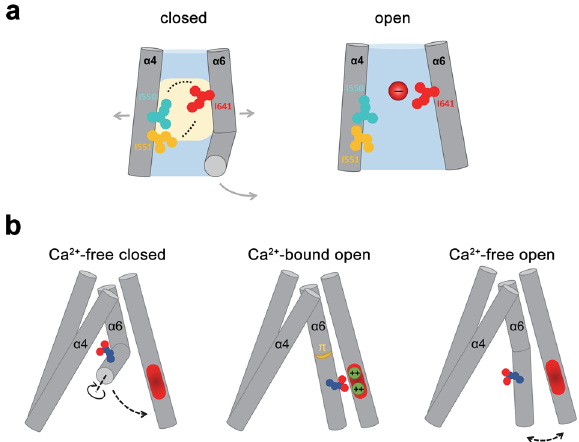
Fig. 7 Relationship between non-conducting and conducting conformations. a Schematic illustration of the hydrophobic gate at the inner entrance of the narrow neck that prevents ion conduction in the closed state (left). Functional interactions between hydrophobic residues are indicated by dashed lines. Beige area indicates putative de-wetted region that excludes water in the closed conformation. In the open conformation (right), the residues of the gate have dissociated leading to a widening of the pore and a retraction of gate residues on α 4. b Relationship between conducting and non-conducting conformations in the presence and absence of Ca 2 + . In the non-conducting apo conformation of WT (left), the intracellular half of α 6 has moved away from the Ca 2 + binding site. Upon Ca 2 + binding, α 6 rearranges its conformation by moving towards the Ca 2 + binding site. The subsequent rotation around the helix axis, to bring a residue in contact with bound Ca 2 + ions, introduces a strained π -helix conformation. The movement of α 6 couples to the gate region to open the channel (center). The coupling between the gate and α 6 is illustrated in the structure of a gate mutant showing basal activity in the absence of Ca 2 + (right). In this case, α 6 has approached the vacant binding site, opening the gate without transiting to a strained π -helix